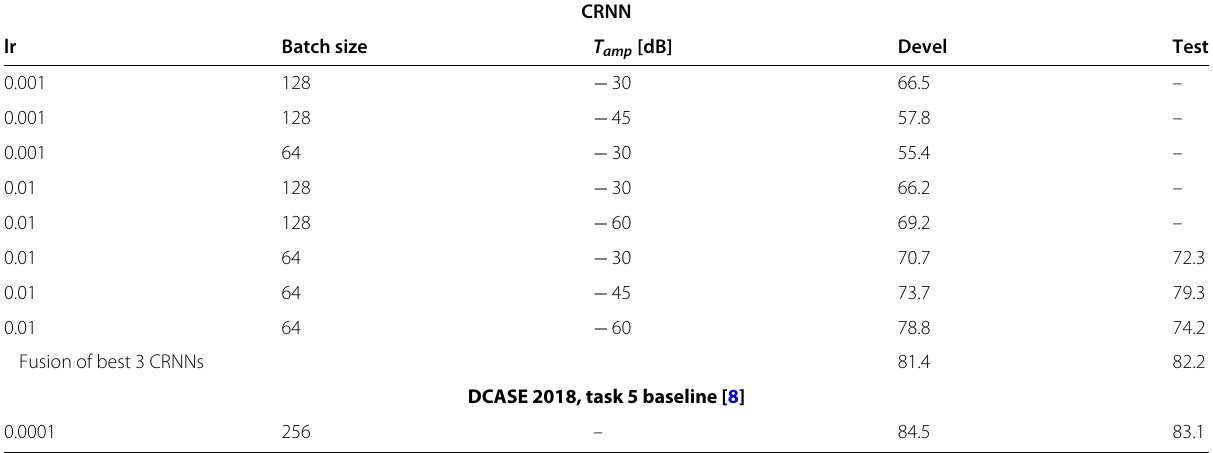
Table 1 Performance of CRNNs. All results are given in macro average F1. T amp amplitude threshold, lr learning rate. All results are measured in macro average F1